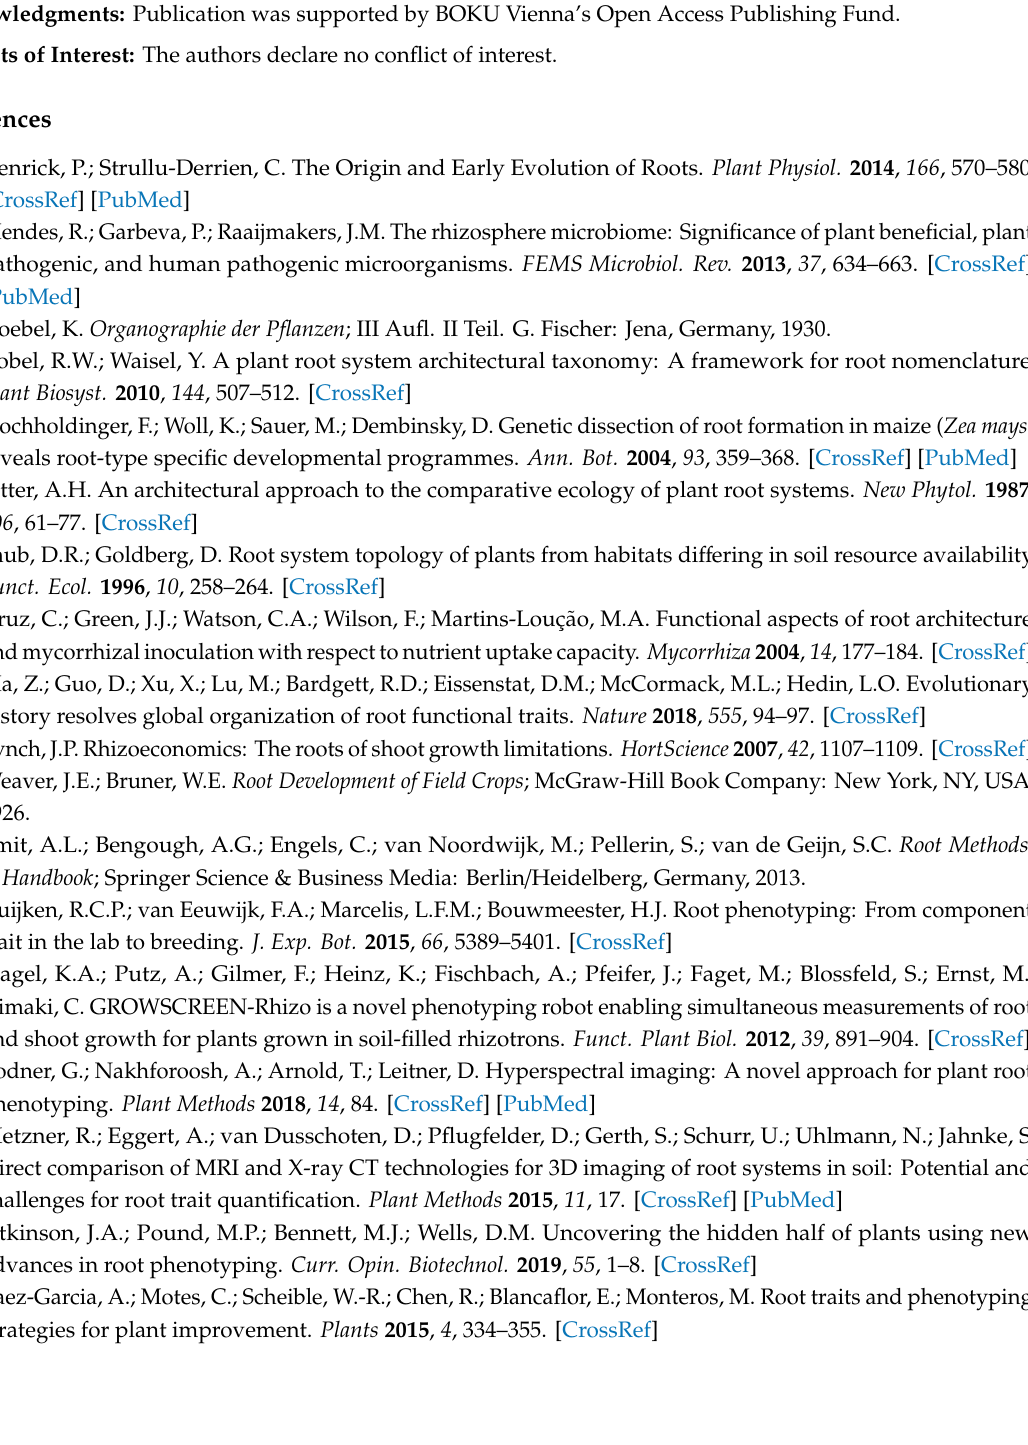
Figure S1: Root length distribution over diameter for ten di ff erent cover crop species from rhizobox